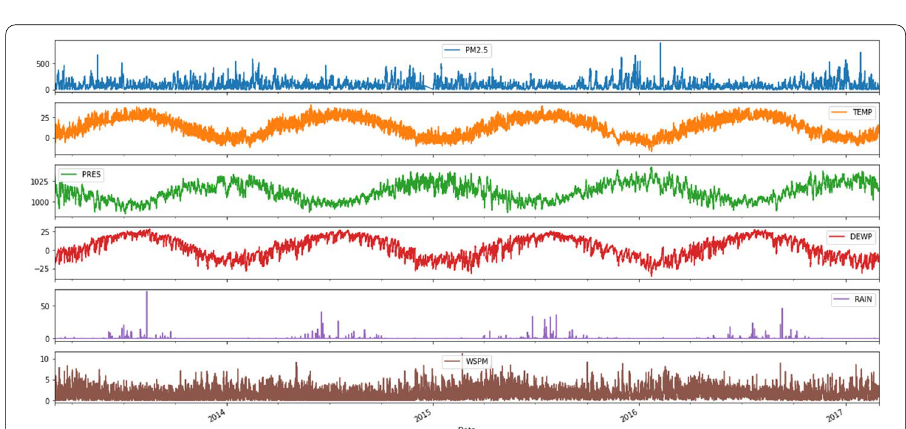
Fig. 9 Graphical representation of Meteorological data and PM